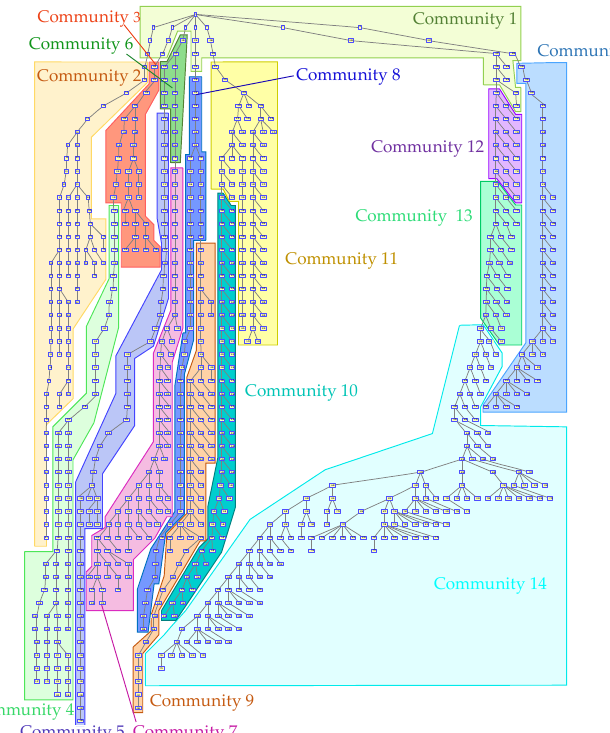
Figure 3. Community structure of the NDSU 881 test case.